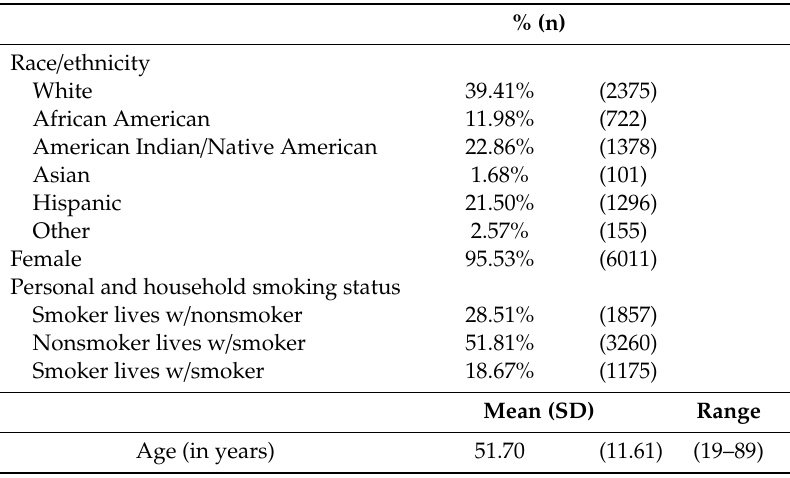
Table 1. Demographic Details of Direct Mail Recipients.